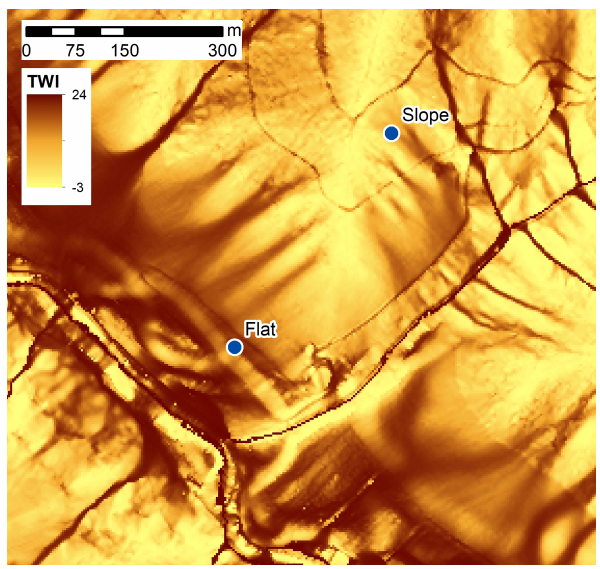
Figure 12. Topographic wetness index (TWI) at the study sites ac- cording to Beven and Kirkby (1979). The extract corresponds to the extent in Fig.